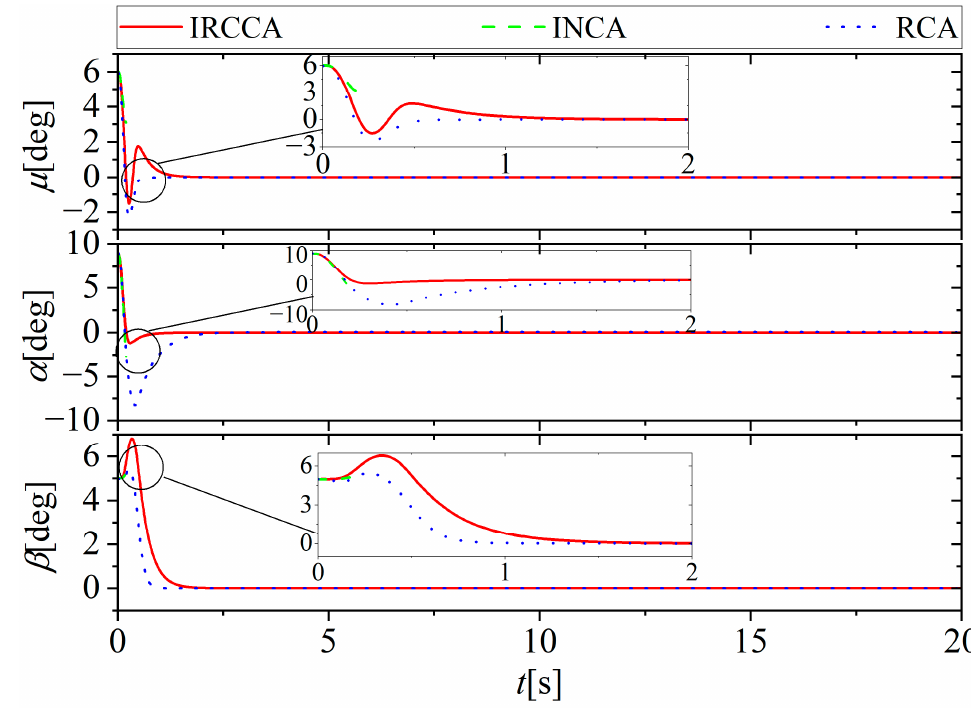
Figure 17. Time response of the attitude angle with multiple faults.